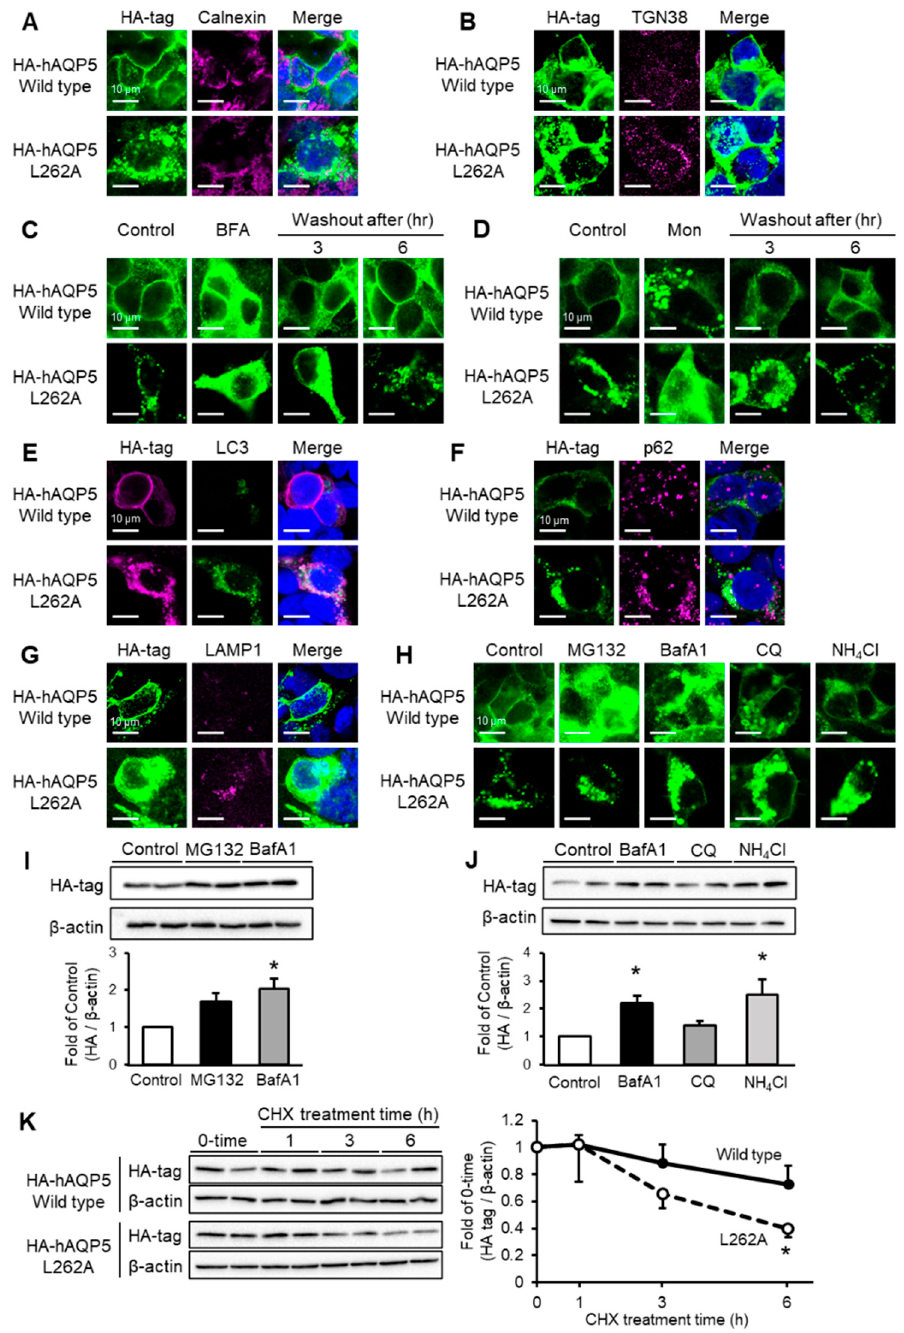
Figure 4. C-terminal domain mutant of AQP5 localizes to autophagosome or lysosome and is degraded via autophagy. HEK-293 cells transfected with hAQP5 wild-type or L262A were analyzed for the cellular localization of the mutants, calnexin ( A ) or TGN38 ( B ), by immunofluorescence. HEK-293 cells transfected with hAQP5 wild-type or L262A were treated with brefeldin A (( C ), BFA, 5 µg/mL) or monensin (( D ), Mon, 10 µM) for 12 h, after which the cells were washed out and incubated for 3 or 6 h. The cellular localization of the mutants was assessed by immunofluorescence. HEK-293 cells transfected with hAQP5 wild-type or L262A with LC3-GFP were analyzed for the cellular localization of the mutants and LC3 by immunofluorescence ( E ). HEK-293 cells transfected with hAQP5 wild-type or L262A were analyzed for the cellular localization of the mutants, p62 (F), or LAMP1 ( G ), by immunofluorescence. HEK-293 cells transfected with hAQP5 L262A were treated